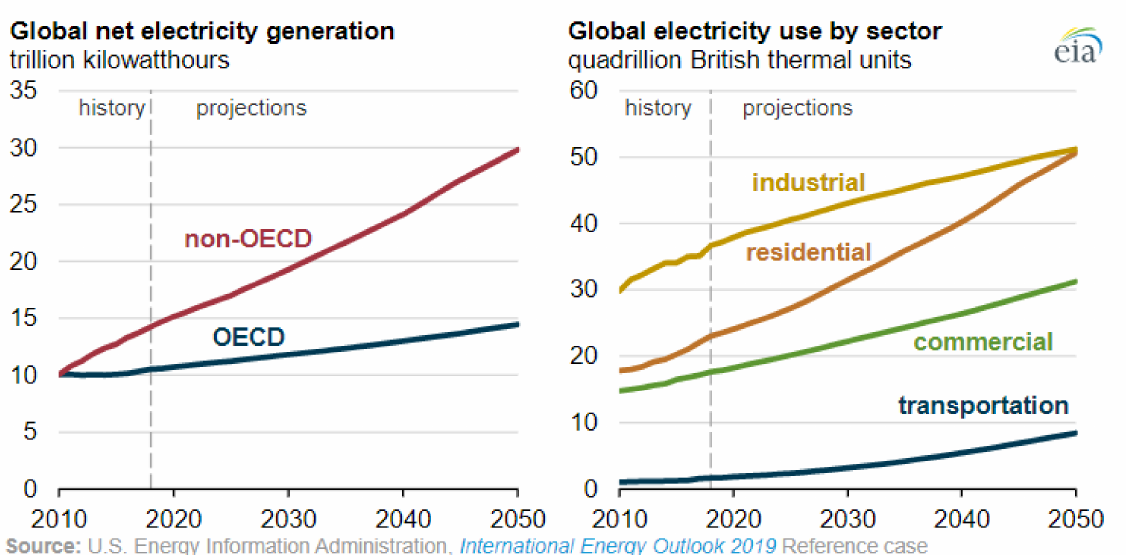
Figure 1. Global electricity generation and